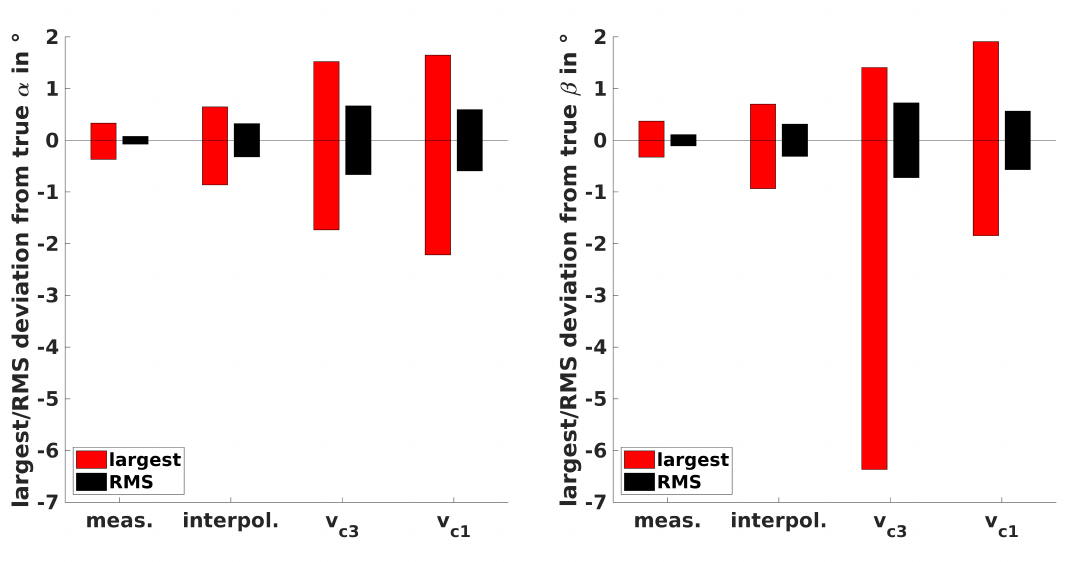
Figure 18. Deviations (largest deviation and root mean squared deviation) of the recalculation of α ( left ) and β ( right ) with the polynomial of the actual calibration at v c 2 (meas.), the interpolated polynomial (interpol.) and the polynomials at v c 3 and v c 1